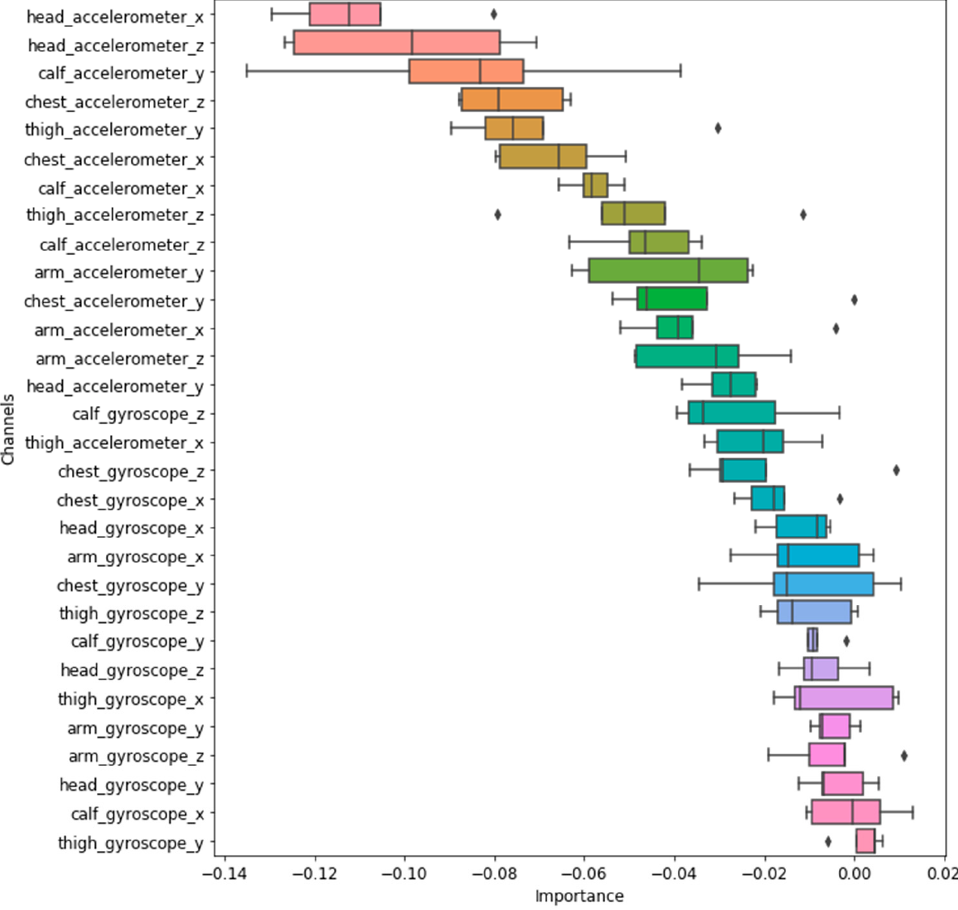
Figure 11. Ranking of feature importance.